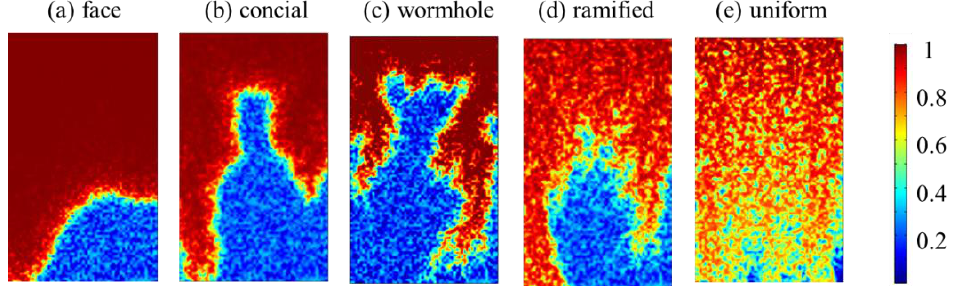
Figure A2. Dissolution patterns under different injection velocity. ( a ) face dissolution, injection velocity 𝑣 0 = 10 −6 cm/s , ( b ) concial dissolution with 𝑣 0 = 5 × 10 −6 cm/s , ( c ) wormhole dissolution with 𝑣 0 = 5 × 10 −5 cm/s , ( d ) ramified dissolution with 𝑣 0 = 10 −4 cm/s , ( e ) uniform dissolution with 𝑣 0 = 5 × 10 −4 cm/s .